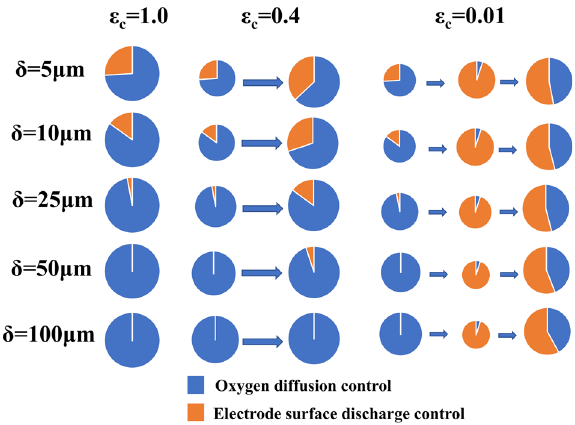
Fig. 6 Schematic diagram of the in fl uence weights of control steps in each corrosion process with different ε and under electrolyte fi lm with different thicknesses. Left: the ε of corrosion products is 1.0. Mid: the ε of corrosion products is 0.4. Right: the ε of corrosion products is